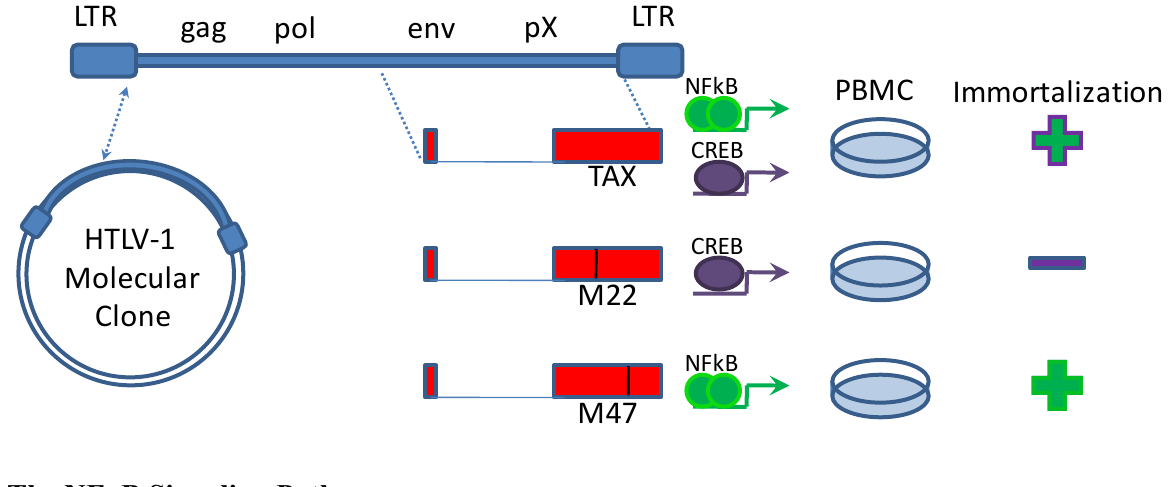
Figure 1. Tax activation of NFκB is required for immortalization. The creation of a molecular clone of HTLV-1 by Kimata et al. [11] enabled the analysis of Tax mutants for immortalization determinants [12]. Mutations that inhibit Tax activation of the NFκB pathway prevented immortalization of peripheral blood mononuclear cells (PBMC), whereas mutations that inhibit Tax activation of the CREB pathway allowed NFκB activation and Tax-mediated